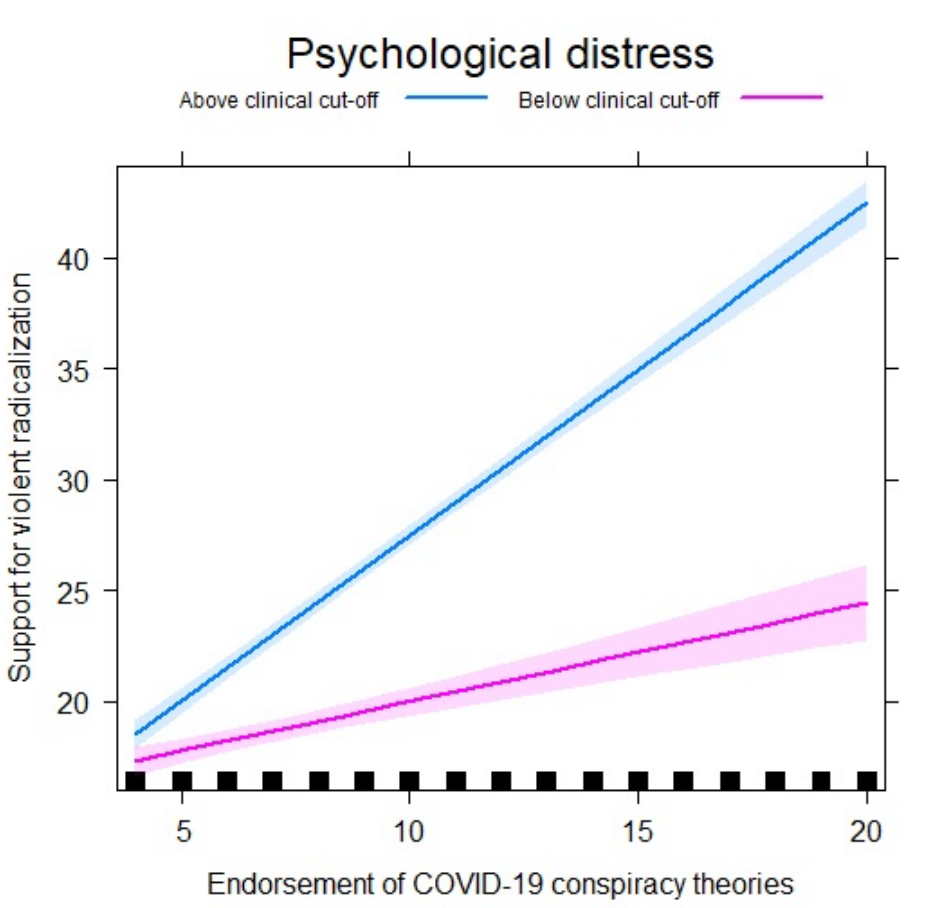
Figure 2. Psychological distress as moderator of the association between sympathy for violent radicalization and endorsement of COVID-19 conspiracy theories.